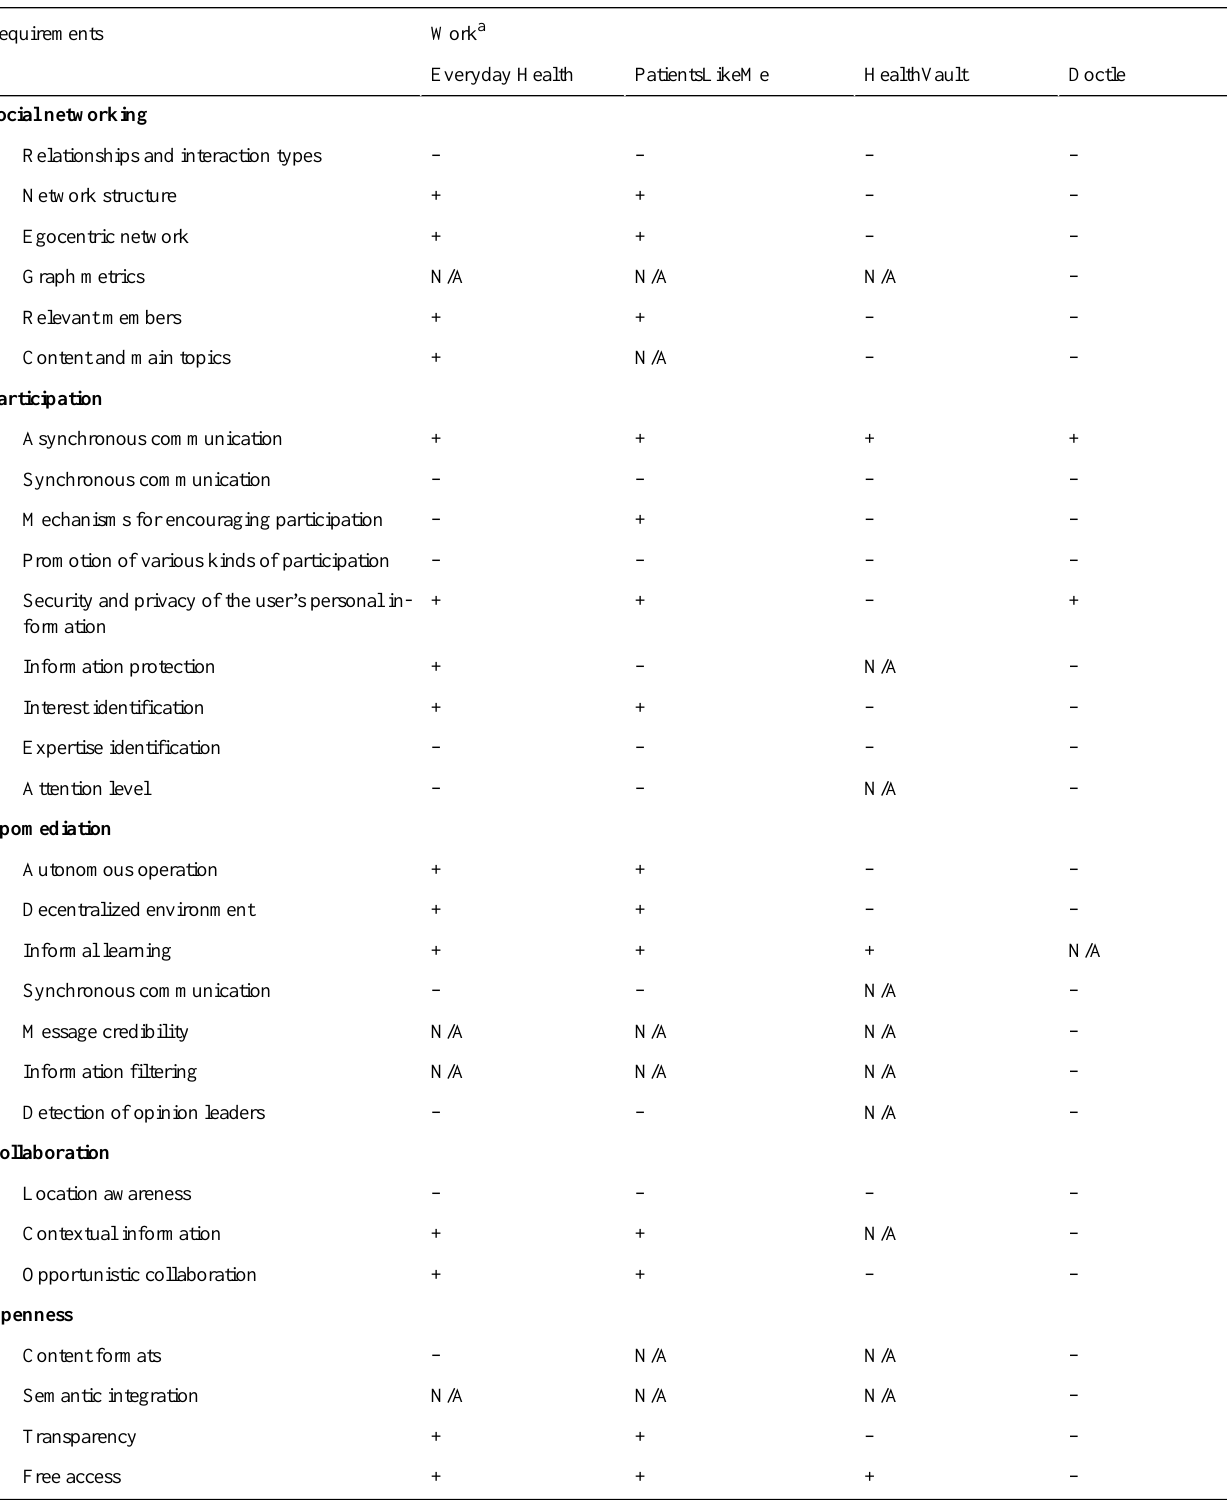
Table 1. Current social networking tools, mobile apps, and online programs: Analysis from Medicine 2.0